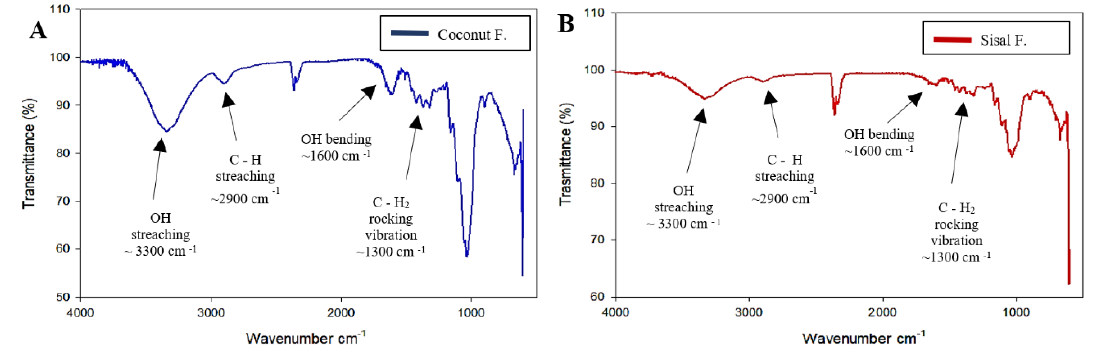
Figure 3. Fourier-transform infrared spectra comparison of ( A ) coconut fiber and ( B ) sisal fiber. The spectrum of both fibers are similar to the expected spectrum of commercial cellulose, in addition these spectrums serve to verifying the efficacy of the purification process.